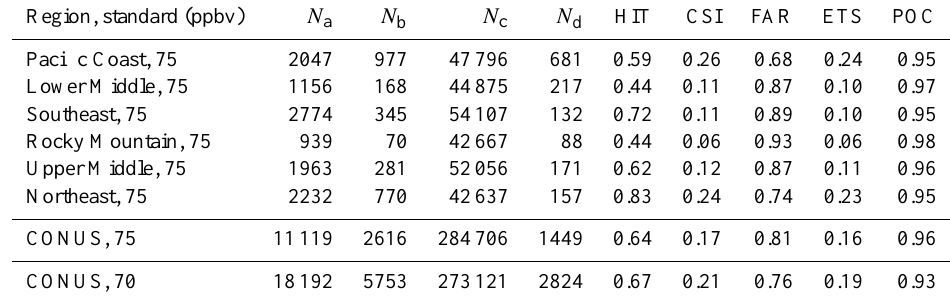
Table 5. Daily maximum eight-hour ozone categorical statistics for 2010, with the 75 and 70ppbv thresholds. See text for details. Region, standard (ppbv) N a N b